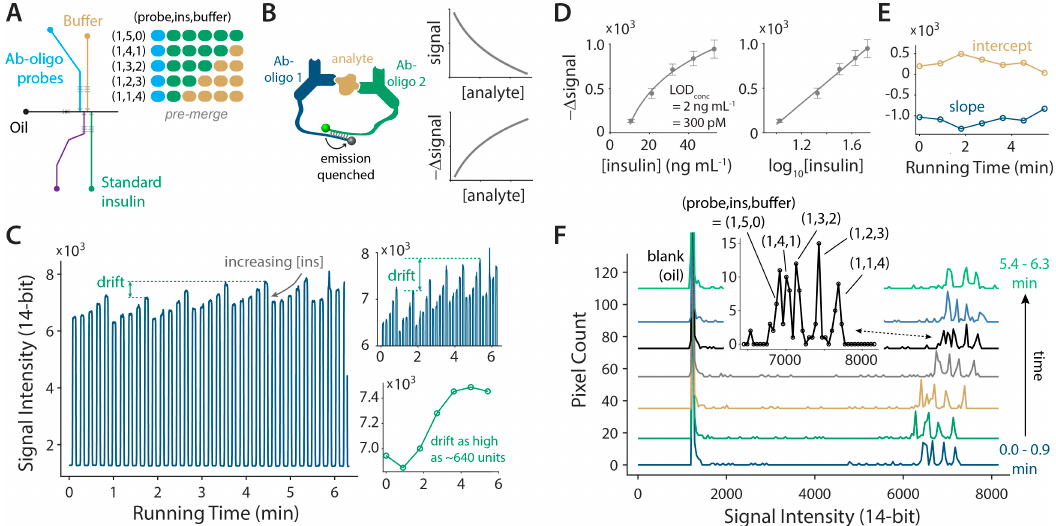
Figure 4. Automated homogeneous immunoassays in nanoliter droplets. ( A ) Device was operated with three inlets to program the pre-merge ratio of Ab-oligo probe, insulin, and buffer droplets. ( B ) Fluorescence-quenching-based homogeneous immunoassay with Ab-oligo probes. The signal quenching is proportional to the analyte concentration with a nonlinear response curve. ( C ) Raw emission data from the automated continuous calibration. The upper inset is a zoomed view of the detector drift, and the lower inset shows that the magnitude of the drift is similar to the overall assay response. ( D ) Lock-in detection with the μ Chopper method allows for a reliable correction and calibration. The signal change is shown versus [insulin] (left) and log 10 [insulin] (right). LOD conc = 2 ng mL − 1 = 300 pM, while LOD amt = 5 amol. ( E ) The continuous linear calibration parameters versus log 10 [insulin] show the slope and y-intercept to be responsive to significant detector drifts. ( F ) The intensity histograms show that the assay responses over the 10–50 ng mL − 1 insulin range were closely clustered, and drift could also be observed. The calibration standards followed the drift, giving reliable calibrations over time as in part ( D , E ).